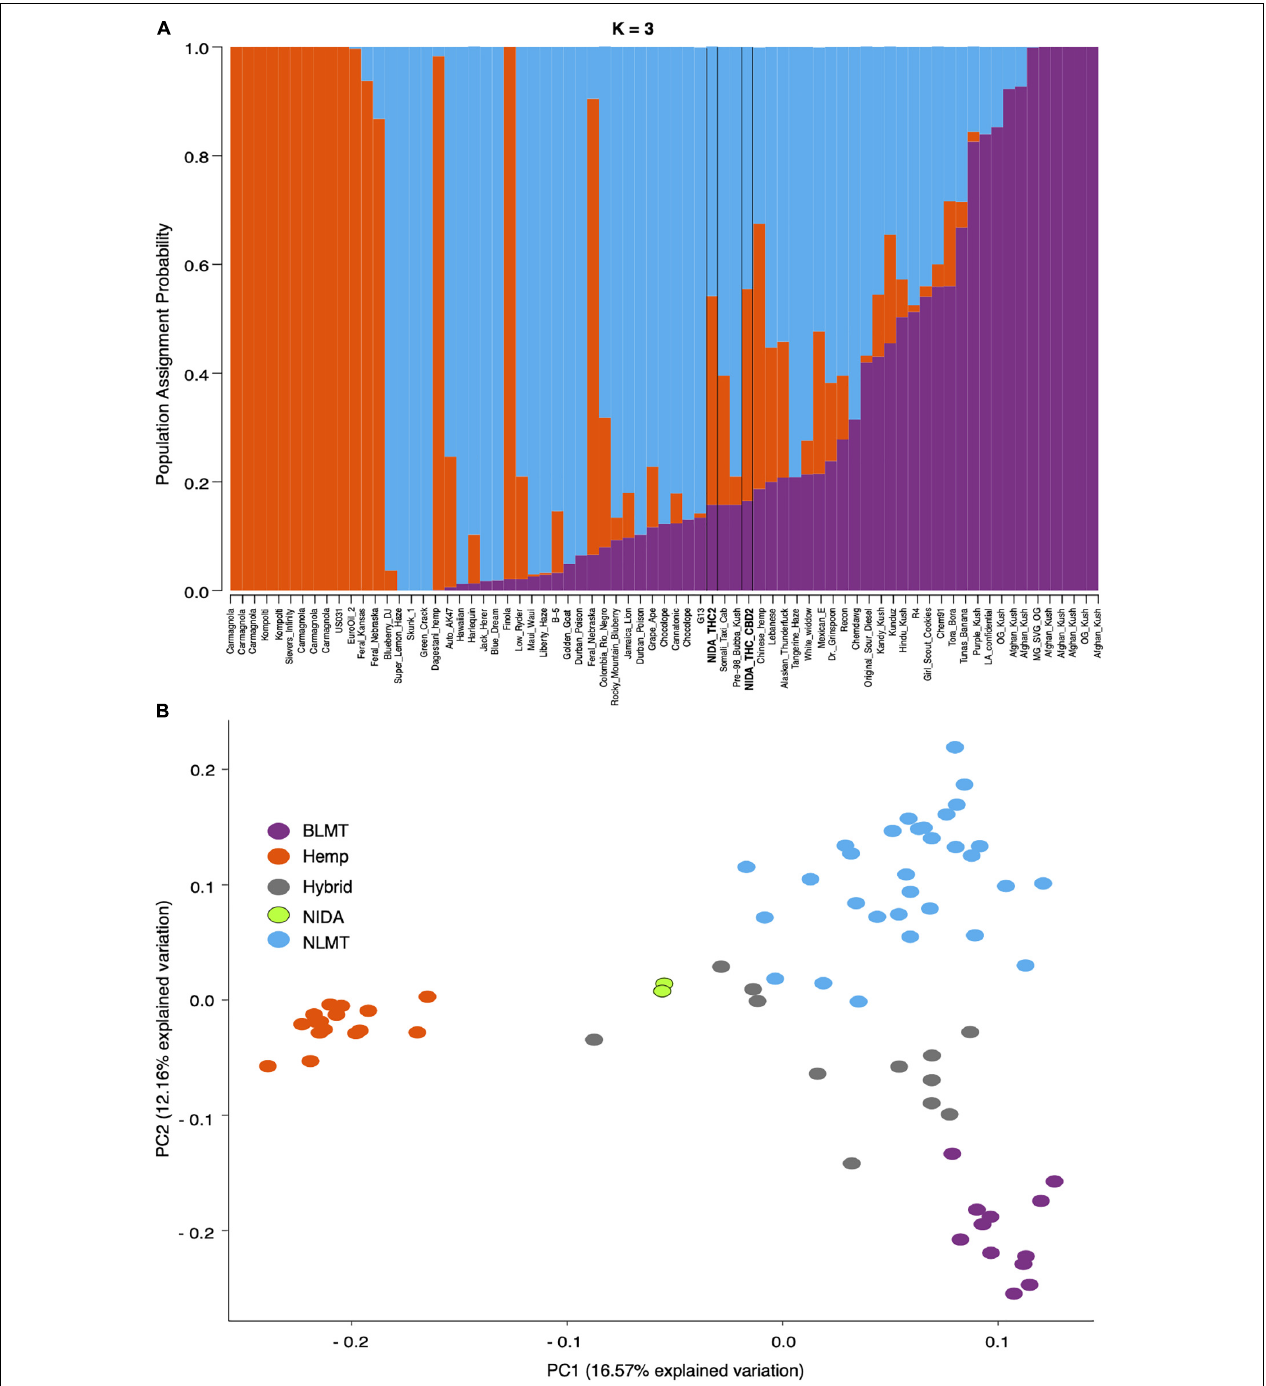
FIGURE 1 | STRUCTURE and Principal Component Analyses. Proportion of each color in the bar indicates the probability of assignment to Hemp (orange), NLMT (blue), or BLMT (purple), groups. Both of NIDA’s strains outlined with black margins are assigned to both NLMT and Hemp groups with less than 60% probability, and therefore we assigned them to the Hybrid group (A) . The two NIDA samples in green cluster with each other and away from other varieties (B)